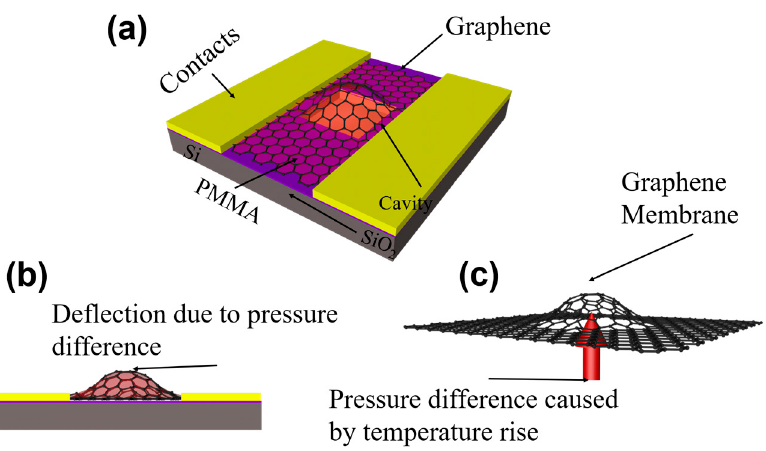
Figure 1. The working principle of the graphene temperature sensor. ( a ) Structure diagram of the graphene temperature sensor. ( b ) Representation of membrane functionality in a graphene temper- ature sensor. ( c ) Representation of sealed gas function in the cavity in a graphene temperature sen- sor.